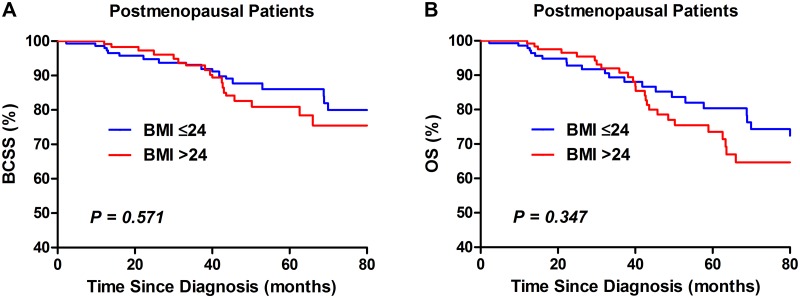
Kaplan–Meier curves of BCSS (A) and OS (B) by BMI groups in postmenopausal TNBC patients.